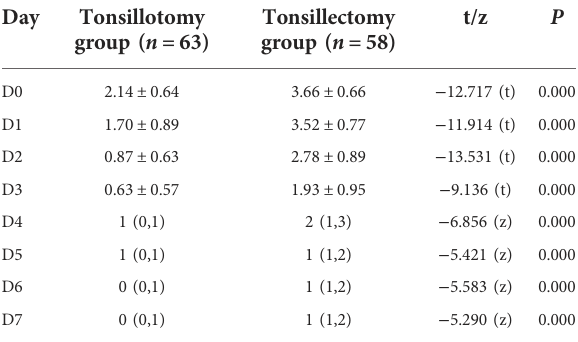
TABLE 3 Comparisons of pharyngeal swelling between the tonsillotomy and tonsillectomy groups. Day